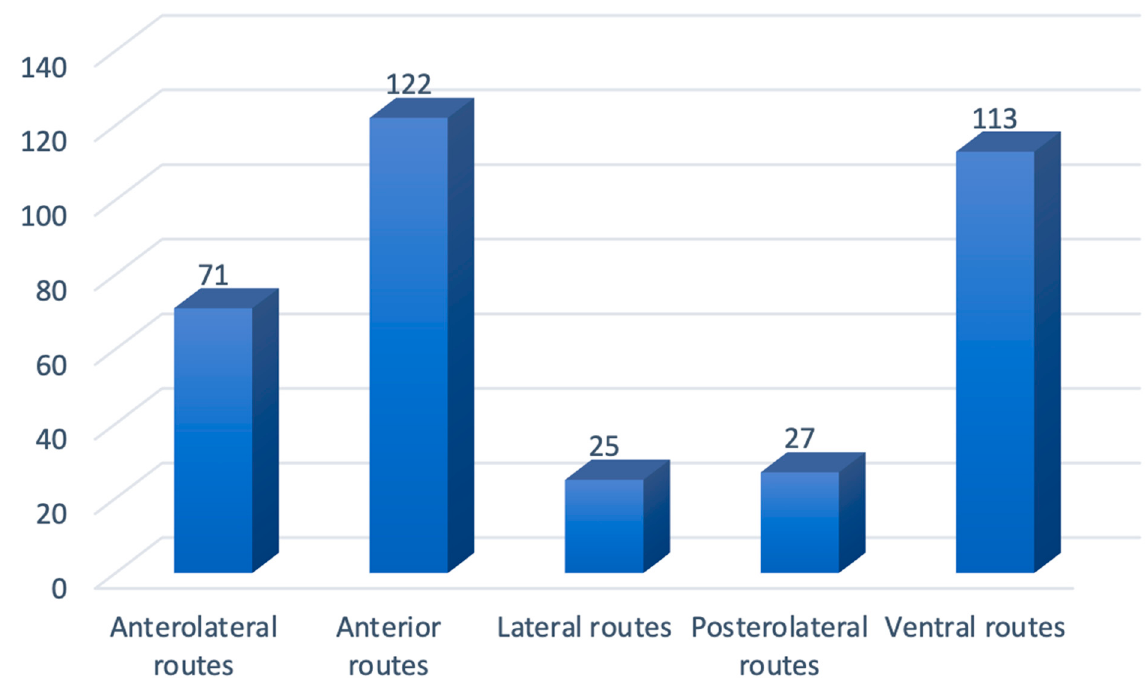
Figure 5. Overall distribution of papers per approach.